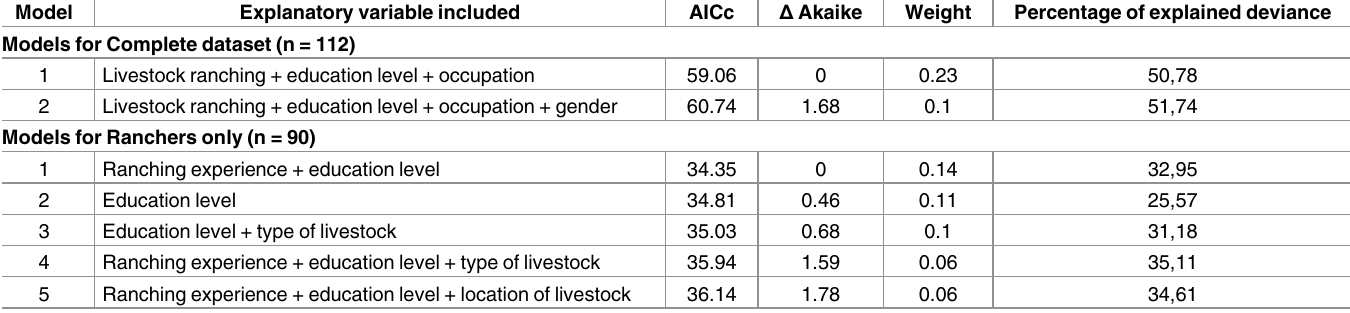
Table 3. Generalized linear models with binomial distribution were used to test for factors that have a significant effect on people’s perception of the Andean condor in Valle Fe´rtil, San Juan, Argentina.